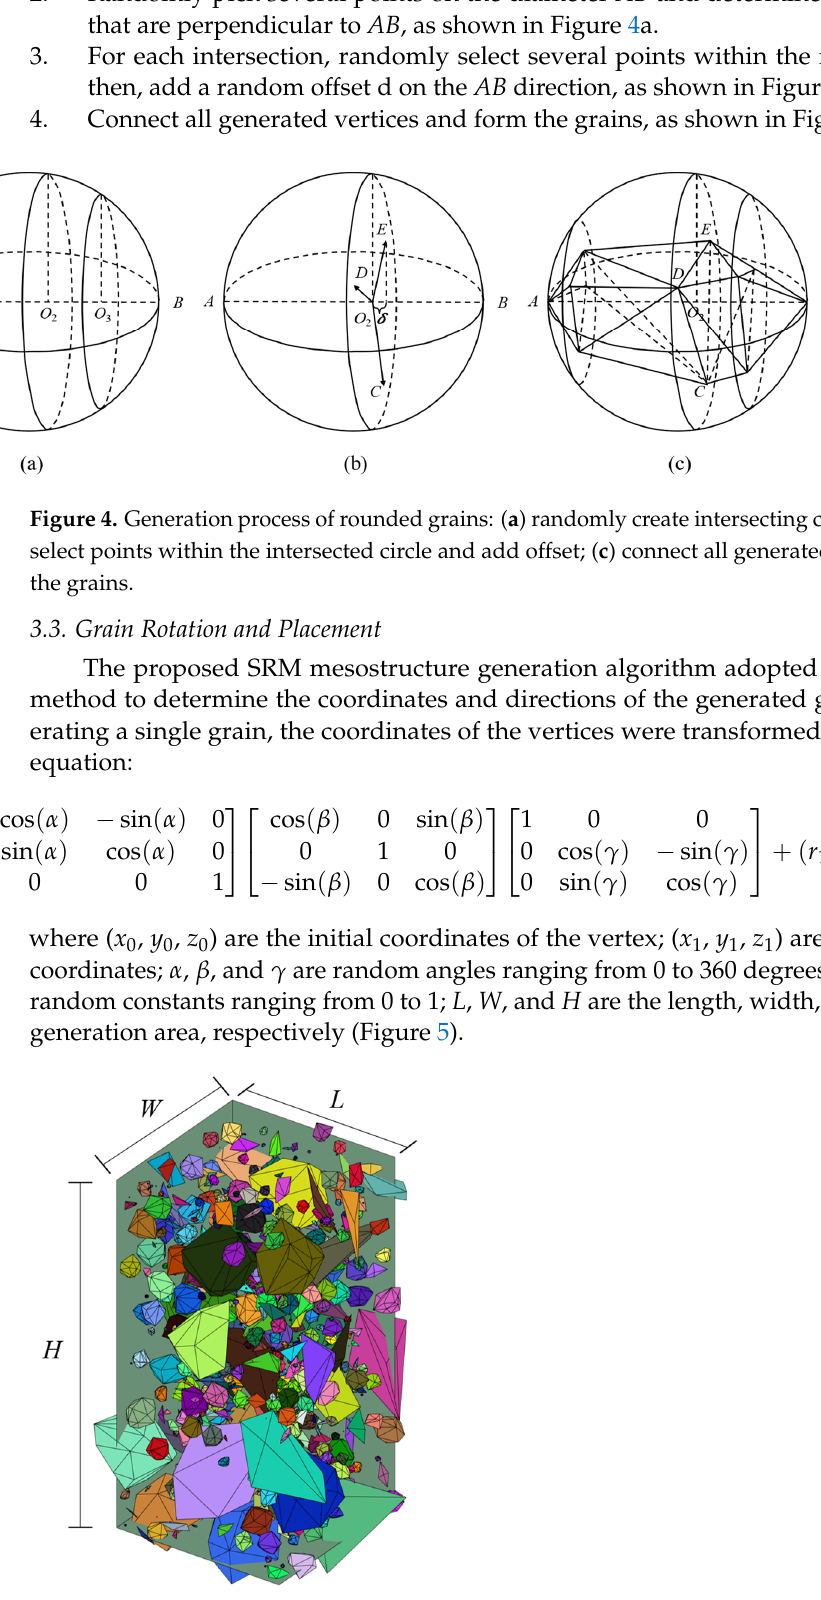
Figure 5. Example of the generated SRM mesostructure.